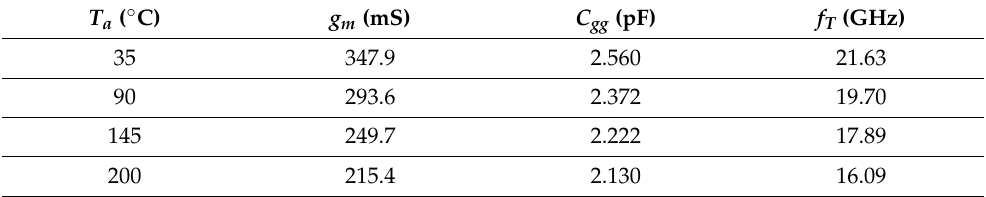
Table 4. Values of g m , C gg , and f T as a function of T a for a GaN HEMT at V DS = 30 V and V GS = − 3.1